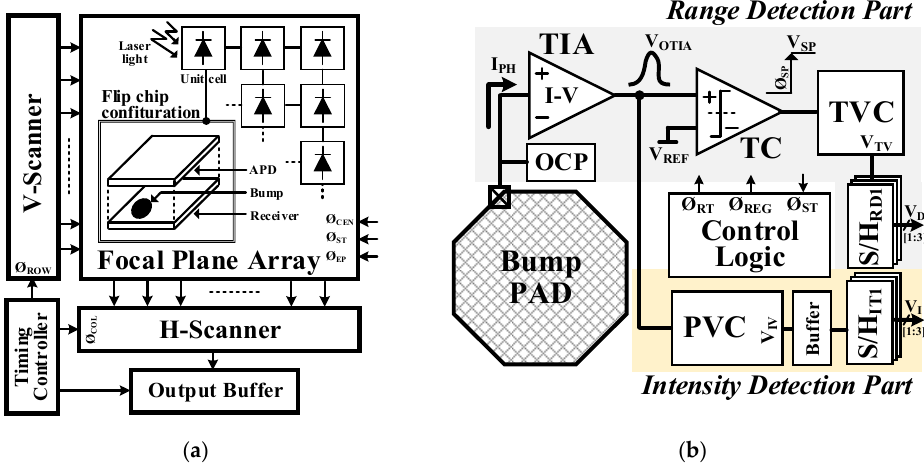
Figure 3. ( a ) overall block diagram and ( b ) simplified block diagram of the proposed